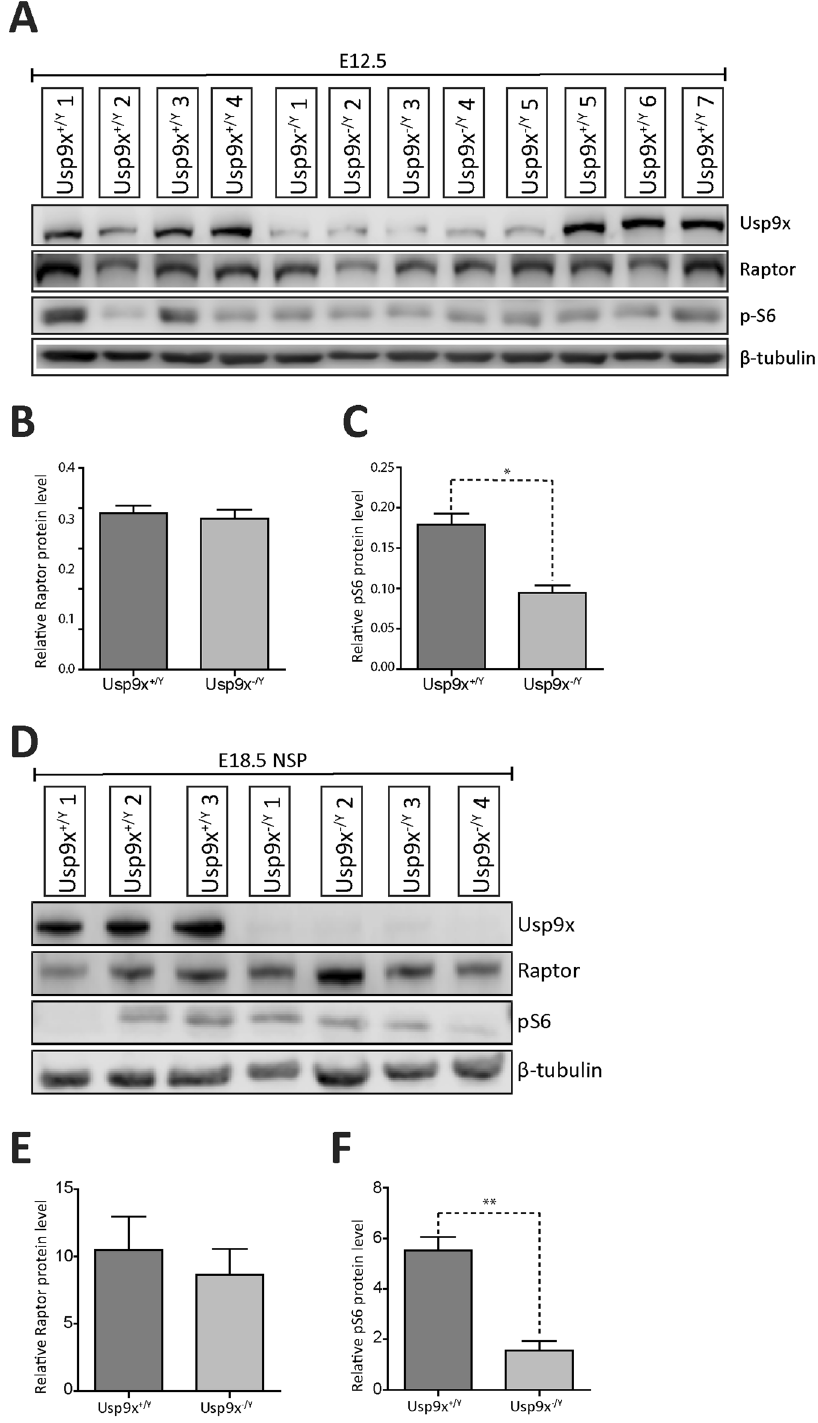
Figure 6. USP9X binds RAPTOR and regulates mTORC1 activity in vivo . ( A ) Immunoblot analysis of Usp9x, Raptor and pS6 protein from E12.5 Usp9x + / Y (n = 7) and Usp9x − / Y (n = 4) mouse forebrains. ( B , C ) Densitometric analysis of (A) revealed no change in Raptor ( B ) but significantly lower levels of pS6 ( C ) protein levels in Usp9x − / y brains. ( D ) Immunoblot analysis of Usp9x, Raptor and pS6 protein from E18.5 derived neurospheres (3 Usp9x + / Y versus 4 Usp9x − / Y ). No difference was observed in Raptor protein levels ( E ) but pS6 levels ( F ) were significantly decreased in Usp9x − /Y neurospheres. All data are shown as the means ± SEM. Statistical significance was assessed by the unpaired Student’s t test. * p < 0.05; ** p <